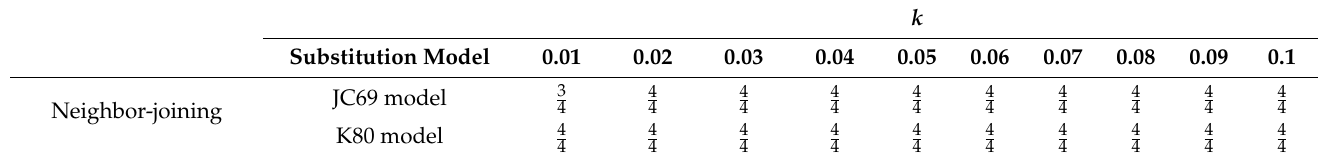
Table 7. The numbers of p -values less than k in the second clade for the trees in Figure 9. The difference between these two models is marked by the red color in the JC69